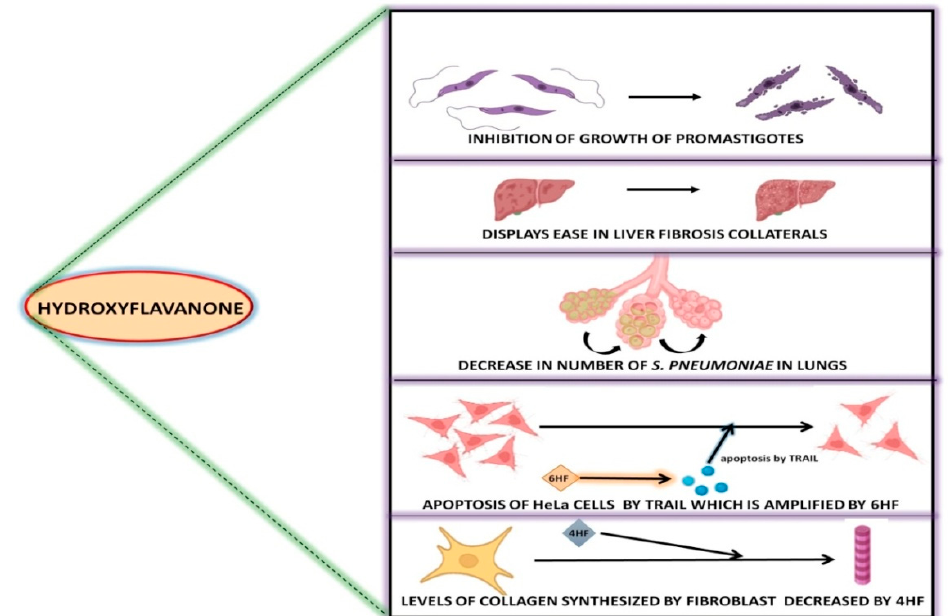
Figure 5. Hydroxyflavanone in diseases other than cancers [51].